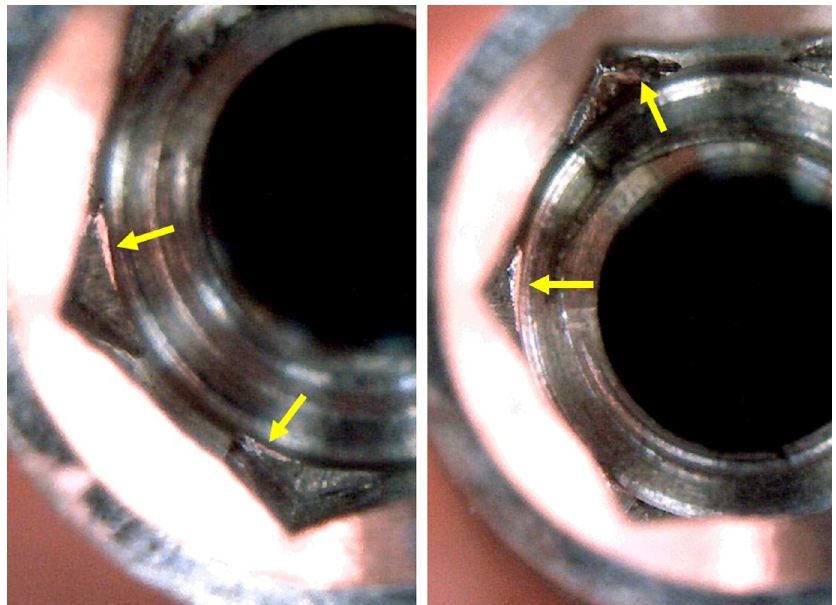
Fig 6. Representative image of samples after the application of 60 and 80 Ncm of torque, respectively. Yellow arrows show the marks in the local where the insertion drive made the force.